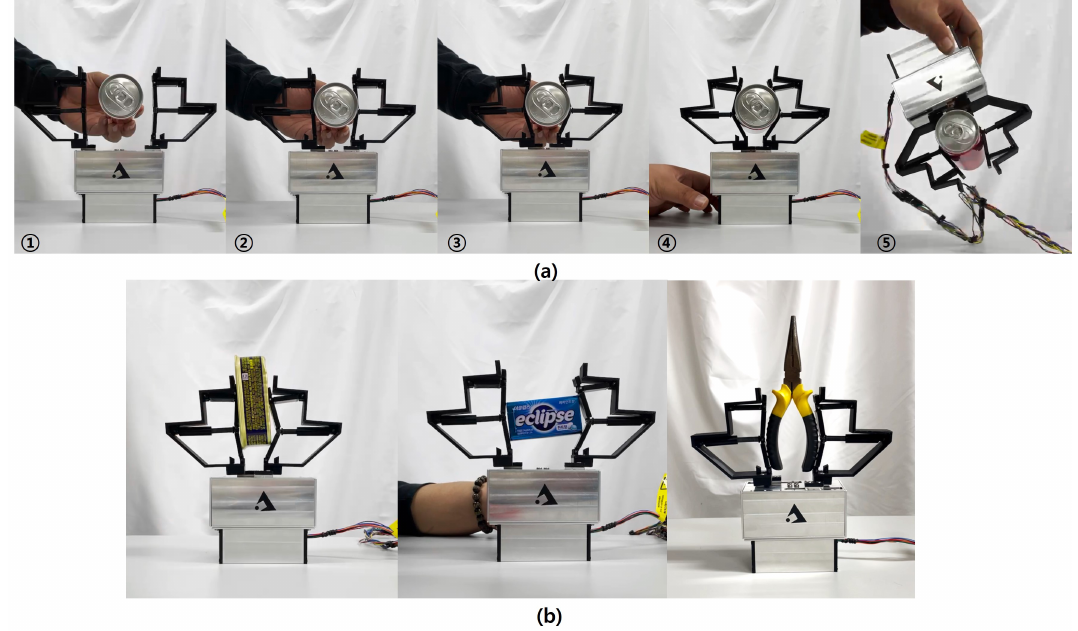
Figure 12. Experimental tests for shape adaptability in the encompassing grasp. ( a ) Sequential steps of the encompassing grasp to hold an unopened soda can (Mass: 276 g, Size: φ = 52.09 mm, and length 132.6 mm); and ( b ) encompassing grasp to hold various objects (Leftmost object: mass 138 g with size 50.36 × 95.2 × 31.6 mm, Middle object: mass 85 g with size 39.45 × 22.93 × 75.9 mm, Rightmost object: mass 166 g).